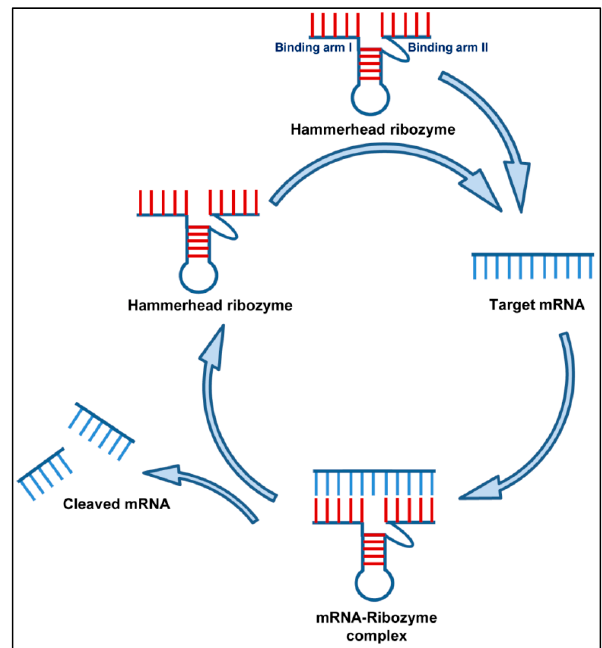
Figure 2. Mechanism of action of Ribozyme. A hammerhead ribozyme has two binding arms